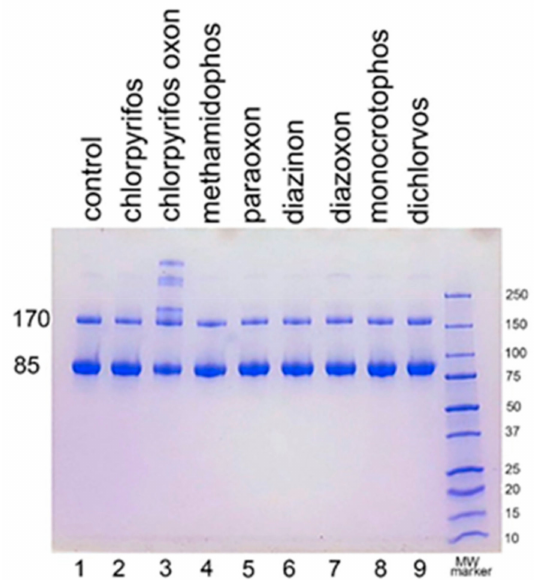
Figure 2. Treatment of human butyrylcholinesterase (HuBChE) with eight organophosphates (OP). Five µ g of HuBChE were loaded per lane. Lanes 2–9 show the results for incubation of HuBChE with the indicated OP. Lane 1 shows the result for incubation without OP. Lane 10 refers to the molecular weight